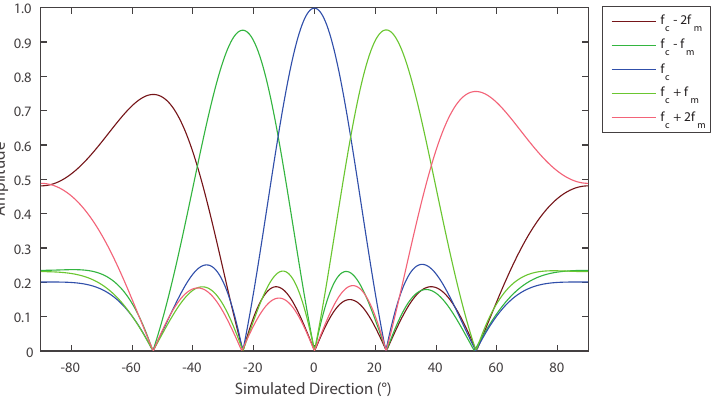
Figure 2. Simulated Array Factor of a five-element array, for five different harmonics when each element is switched on and off uniformly in